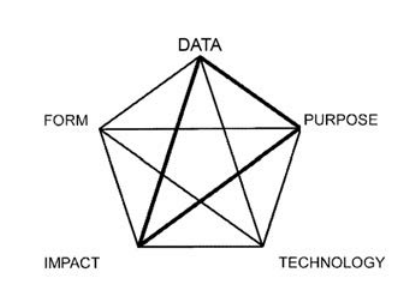
Figure 1. Aspects of visualization research